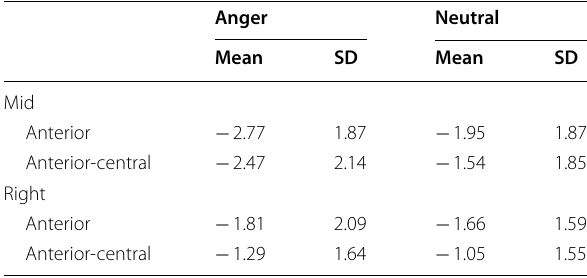
Mean N1 amplitudes and standard deviations (SD) reported separately by Emotion, across electrode positions where the effect of Race was significant: medial, anterior, medial anterior‑central, right anterior, and right